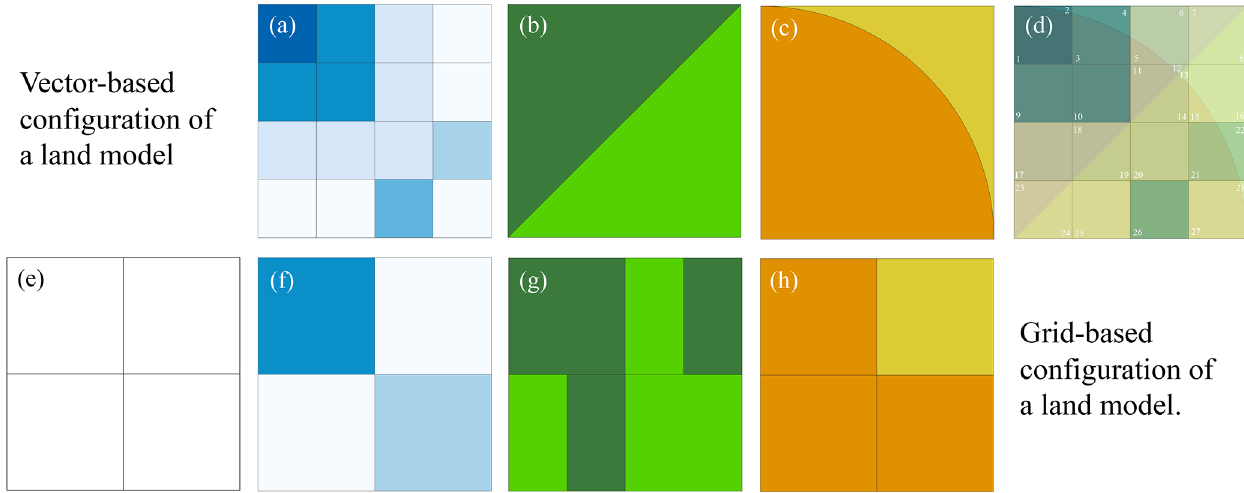
Figure 1. Panels (a–d) indicate vector-based configuration of a land model. (a) Meteorological forcing at its original resolution or upscaled and downscaled resolutions, (b) land covers, (c) soil types with their spatial extent, and (d) vector-based configuration with 28 computational units each with unique forcing, soil type, and land cover type. The bottom row indicates typical grid-based configuration of a land model; (e) a priori resolution should be decided; (f) meteorological forcing should be upscaled or downscaled to the grid resolution; (g) land cover percentage should be calculated for each modeling grid, or a dominate land cover should be selected to represent that grid; and finally (h) soil characteristics for each modeling grid should be